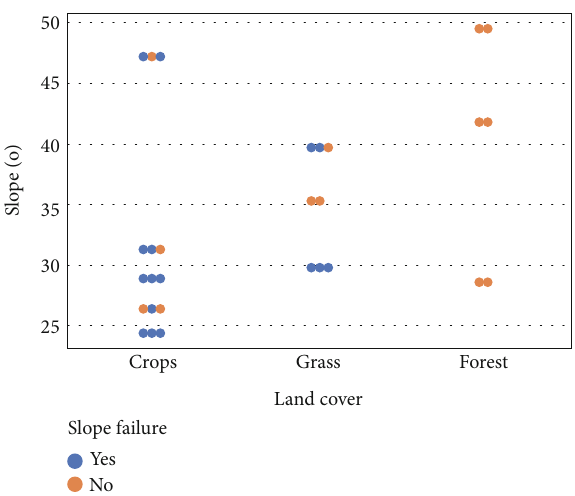
Figure 14: Slope failure vs. soil